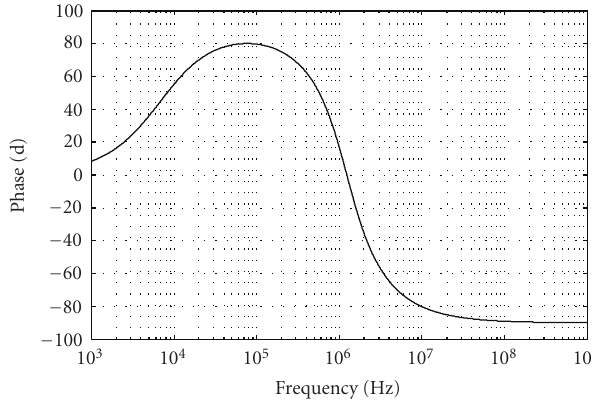
Figure 10: Frequency response of simulated floating inductor.